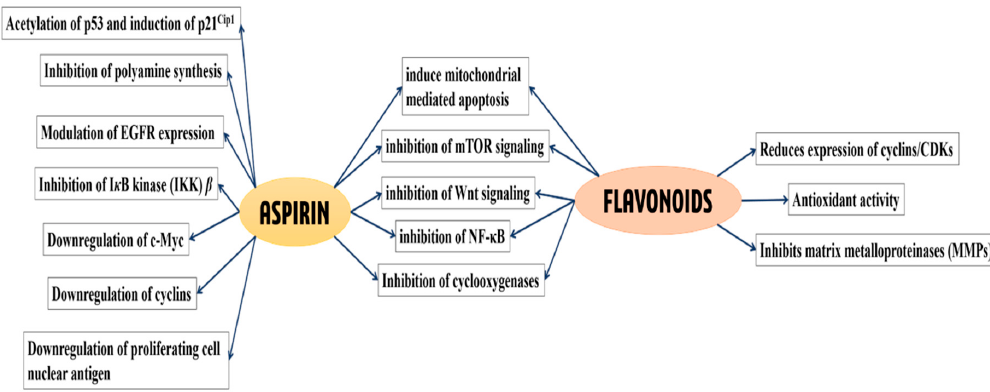
Figure 1. Classical pathways and cellular targets known to be affected by aspirin and flavonoids, leading to the prevention of various cancers. Aspirin and flavonoids affect numerous molecular pathways, some of which overlap. Pathways affected by aspirin alone are indicated in the left, shared pathways are shown in the middle, while pathways affected by flavonoids are shown in the right [6,13,14,33–42].